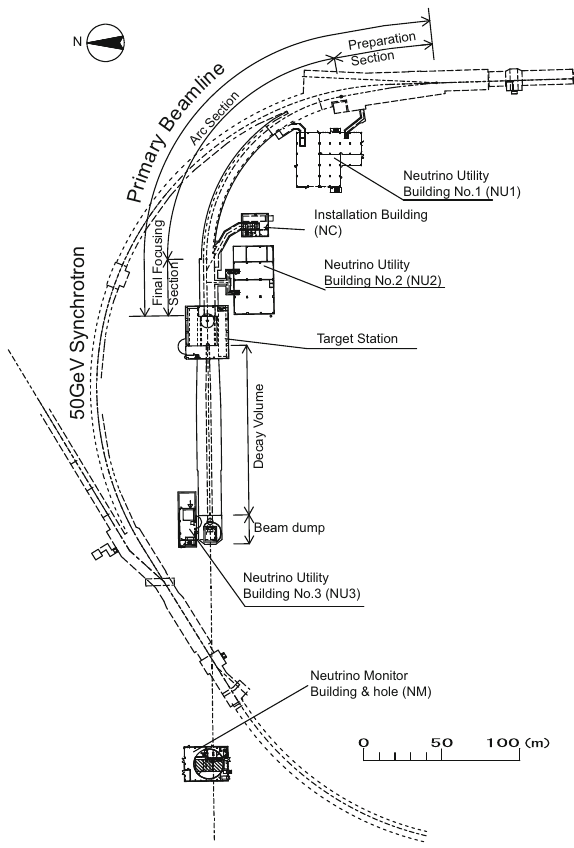
Fig. 46 The layout of the neutrino facility in